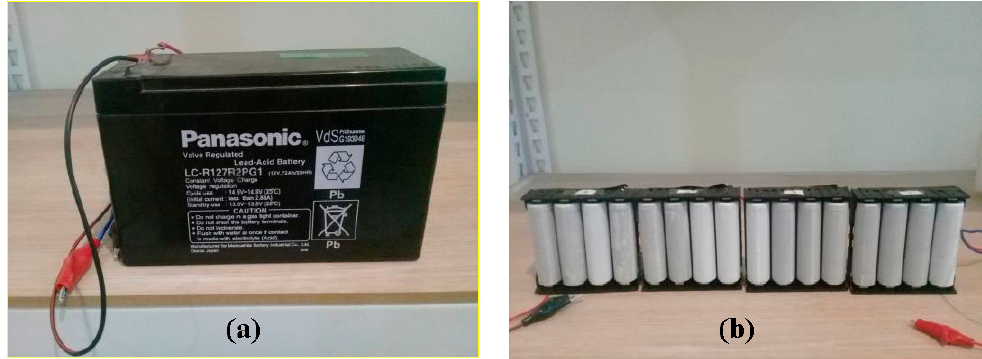
Figure 1. ( a ) VRLA battery; ( b ) LFP battery.